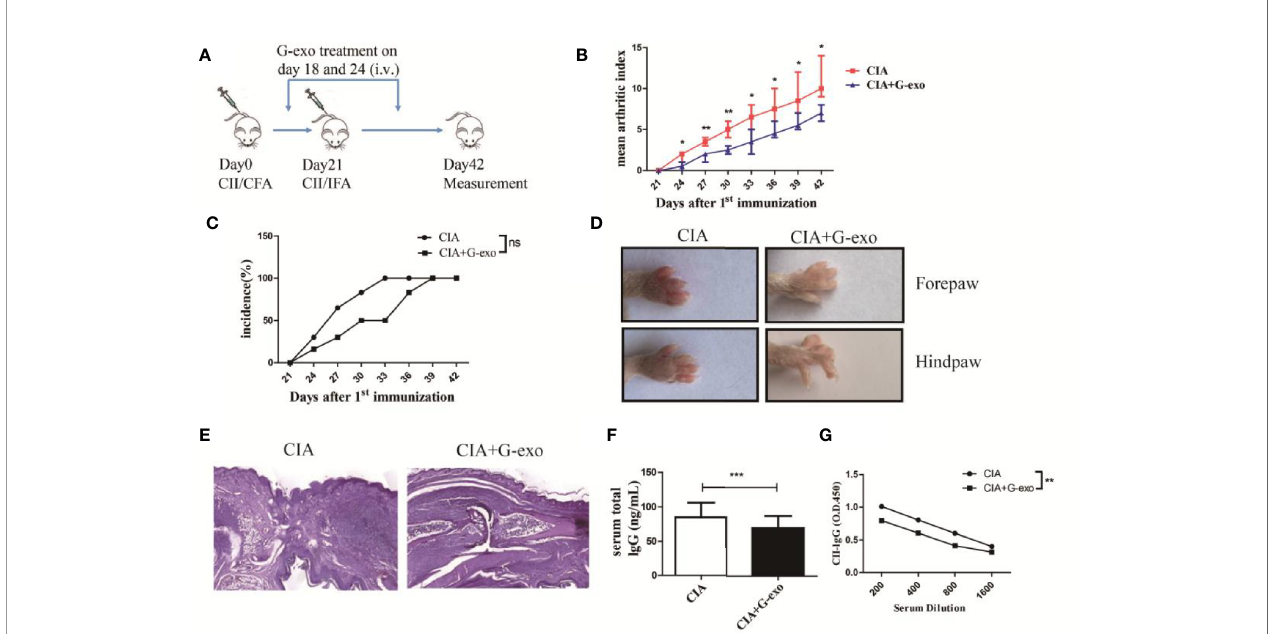
FIGURE 2 | G-exo attenuate collagen-inducedarthritis inmice. (A) DBA1/J mice were immunized with CII/CFAonday 0 and boosted with CII/IFA onday 21. The treatment groups were intravenously injected with 100 m g of G-exo (CIA+G-exo)or phosphate buffered saline (control CIA) on days of 18 and 24. (B) The mean arthritis index was assessed once every three daysafter day 21 for the G-exo-treated or control miceaccordingto the criteria for evaluation. (C) Incidence was assessed once everythree days after day 21 for the G-exo-treated or control mice . (D) Images of hindpaws and forepaws of the G-exo-treated or control mice. (E) Hindpaws obtained from G-exo-treated or control mice were analyzed byH&E histologicexamination. (F) Serum levels of total IgG were measuredby ELISA. (G) Serum anti-CII antibody levels were measured by ELISA. Bar graphs show the means ± SD,*P < 0.05; **P < 0.01; ***P < 0.001; nsindicates nosigni fi cance, (n=